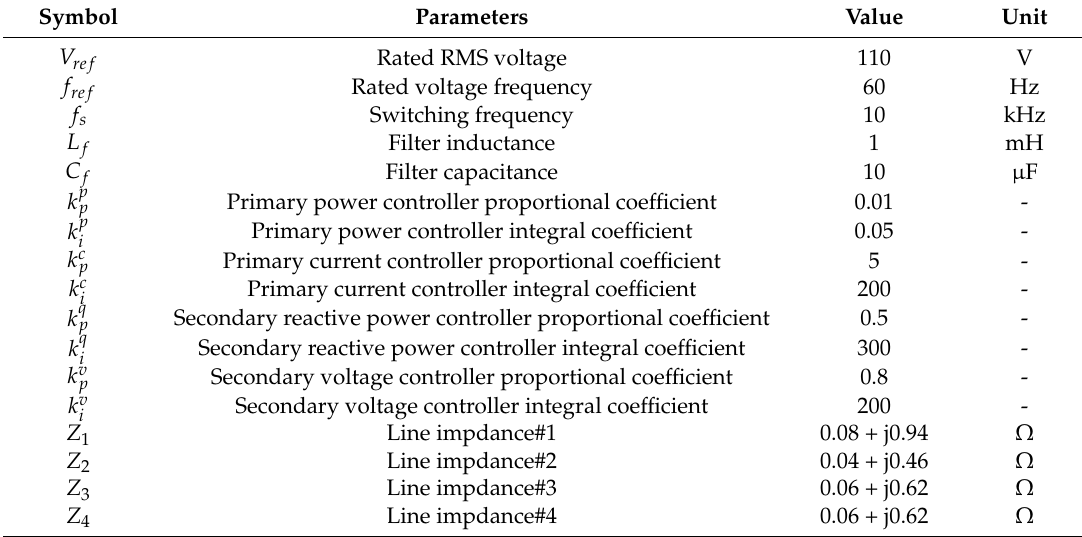
Figure 6. Configuration of the tested microgrid (MG) system. Table 1. System parameters.